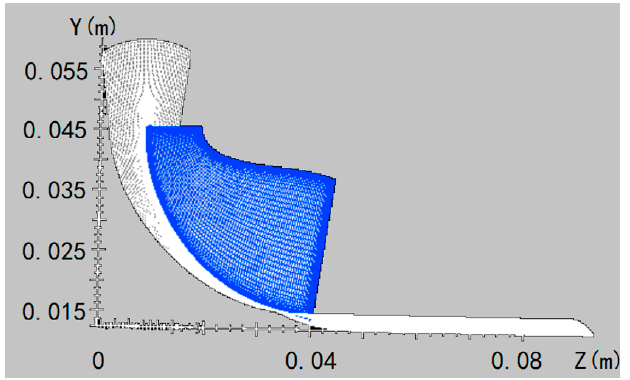
Figure 3. The computational grids of the single passage.